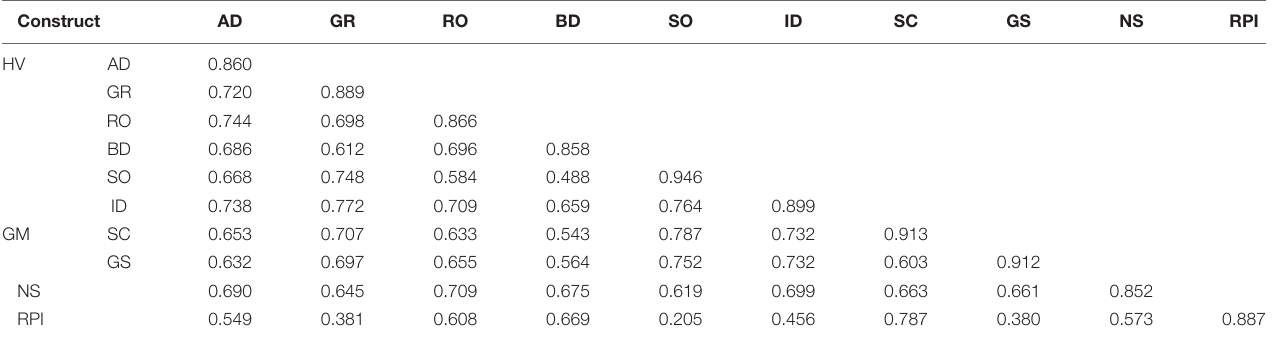
TABLE 5 | Bivariate correlations of the first-order constructs. Construct